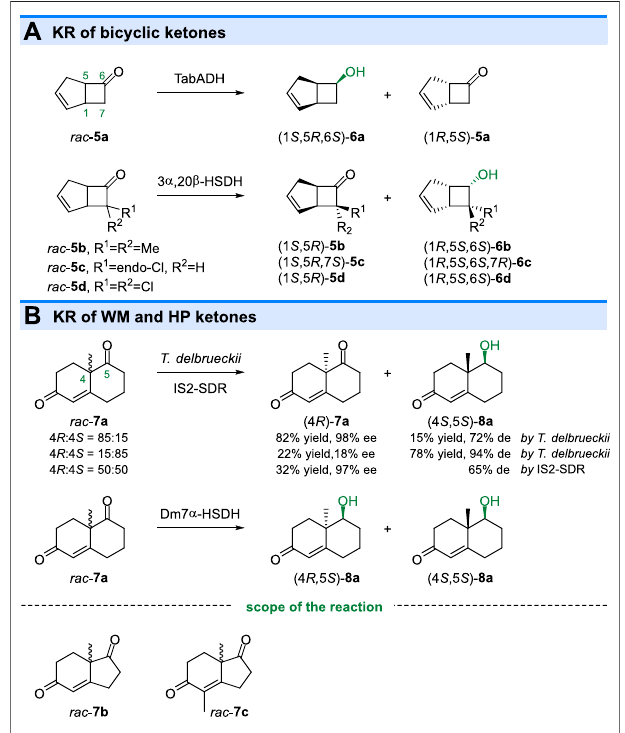
FIGURE 3 | Kinetic resolution of (A) bicyclic ketones and (B) WM/HP ketones.